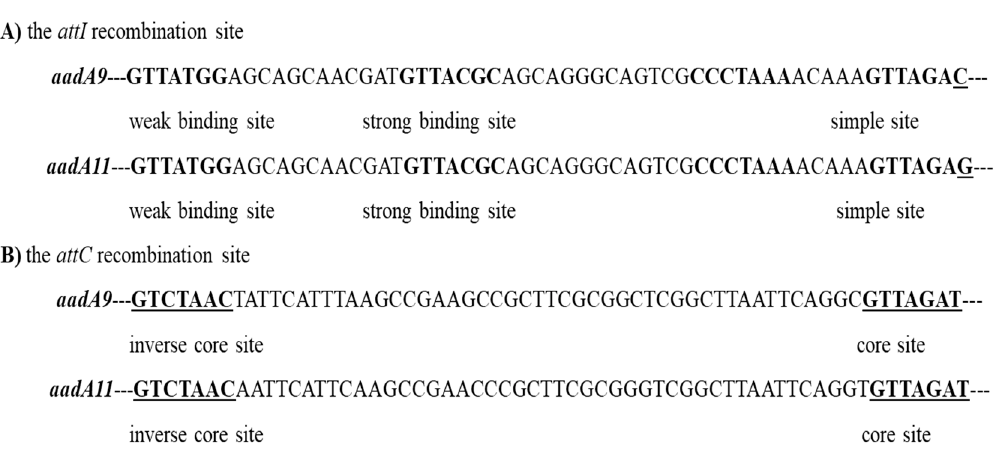
Figure 2. ( A ) Nucleotide sequences of the attI site associated with the class 1 integron gene cassettes aadA9 and aadA11 in studied T. pyogenes isolates. The weak, strong, and simple sites of the class 1 integrase binding are in bold. Differences in one nucleotide in the attI site sequences between aadA9 and aadA11 cassettes are in bold and underlined. ( B ) Nucleotide sequences of the attC sites associated with the class 1 integron gene cassettes aadA9 and aadA11 in T. pyogenes . Sequences of the inverse core sites and core sites for both gene cassettes are in bold and underlined.